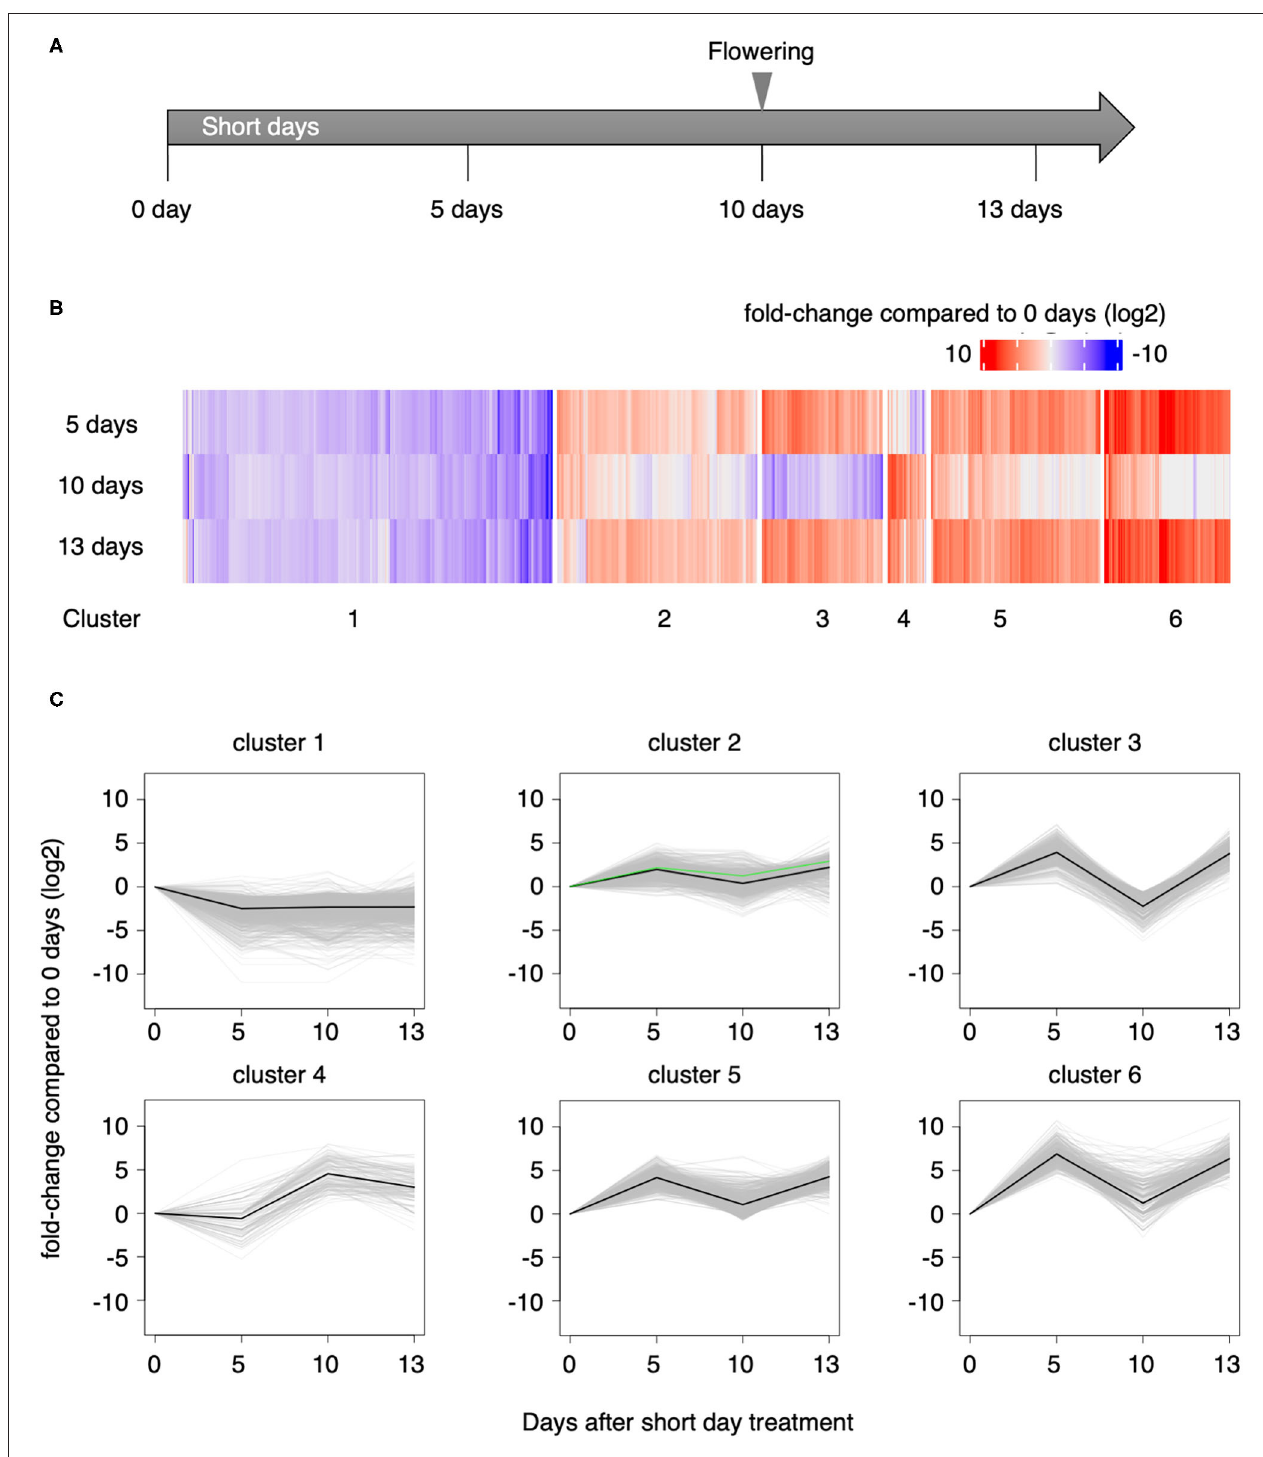
FIGURE 4 | RNA-seq. (A) Time course of sampling L. aequinoctialis after initiating short-day conditions. (B) Heat map of gene expression changes at 5, 10, and 13 days after beginning the short-day treatment compared with the expression level on day 0. (C) K-means clustering of the transcriptome. The green lines in cluster 2 indicate LaFTL1